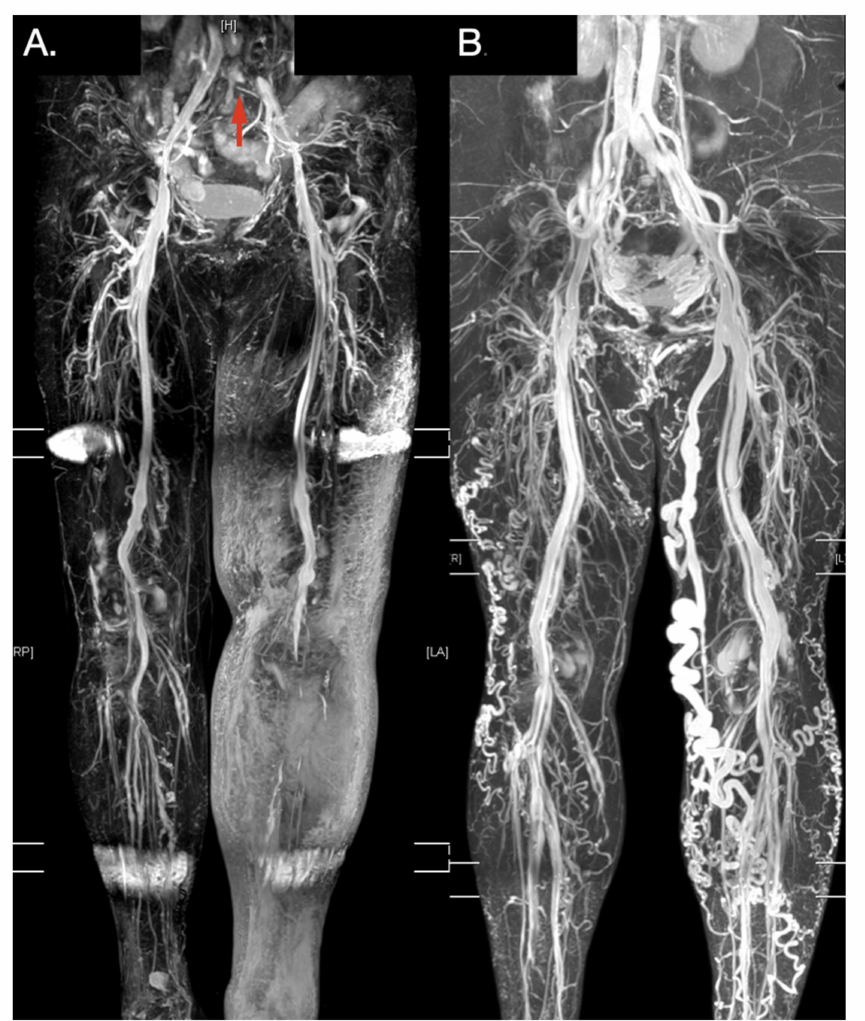
Figure 5. Typical TRANCE MR imaging of obstructive and varicose venous disease. ( A ) Left limb extended subcutaneous edema with a compressed left external iliac vein (Red arrow). ( B ) Lady with left great saphenous varicose vein. Her right thigh received truncal ablation of the right great saphenous vein 4 years